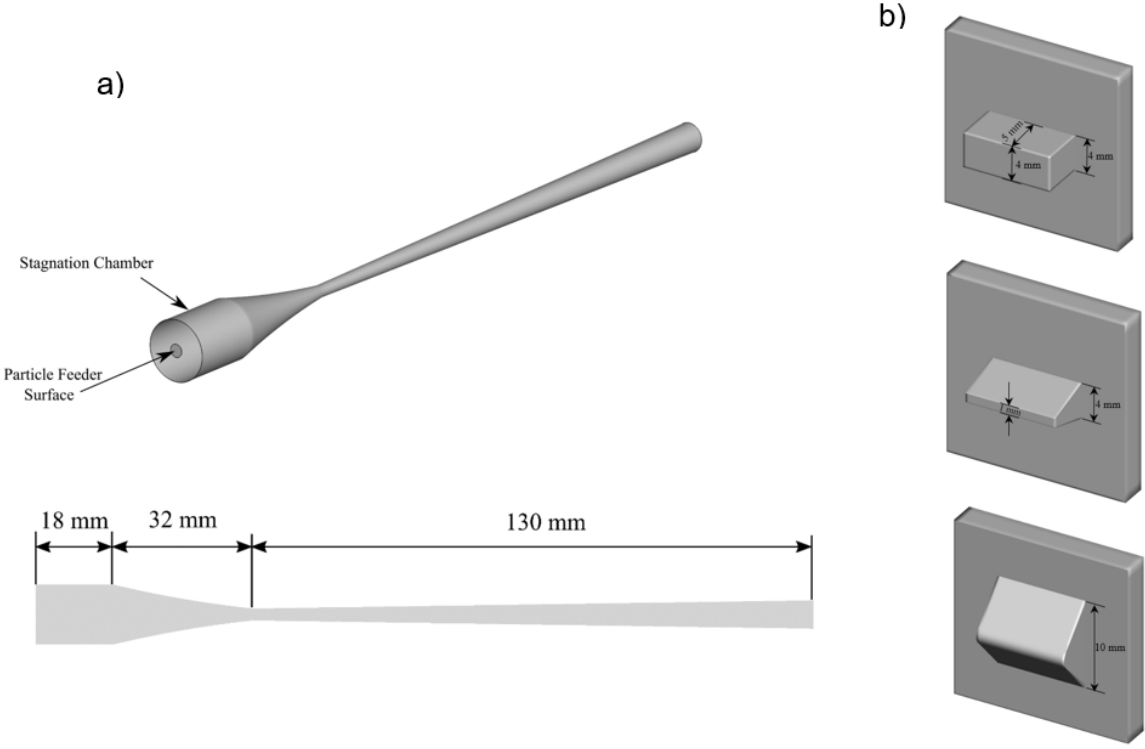
Figure 1. ( a ) Nozzle schematic and ( b ) the objects on top of the flat substrate.